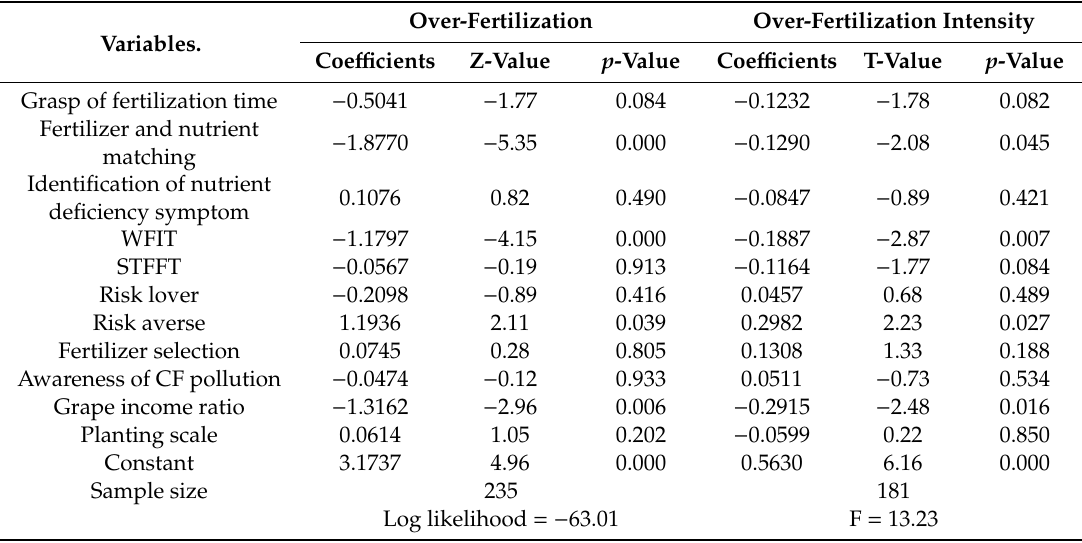
Table 7. Results of the influencing factors of households’